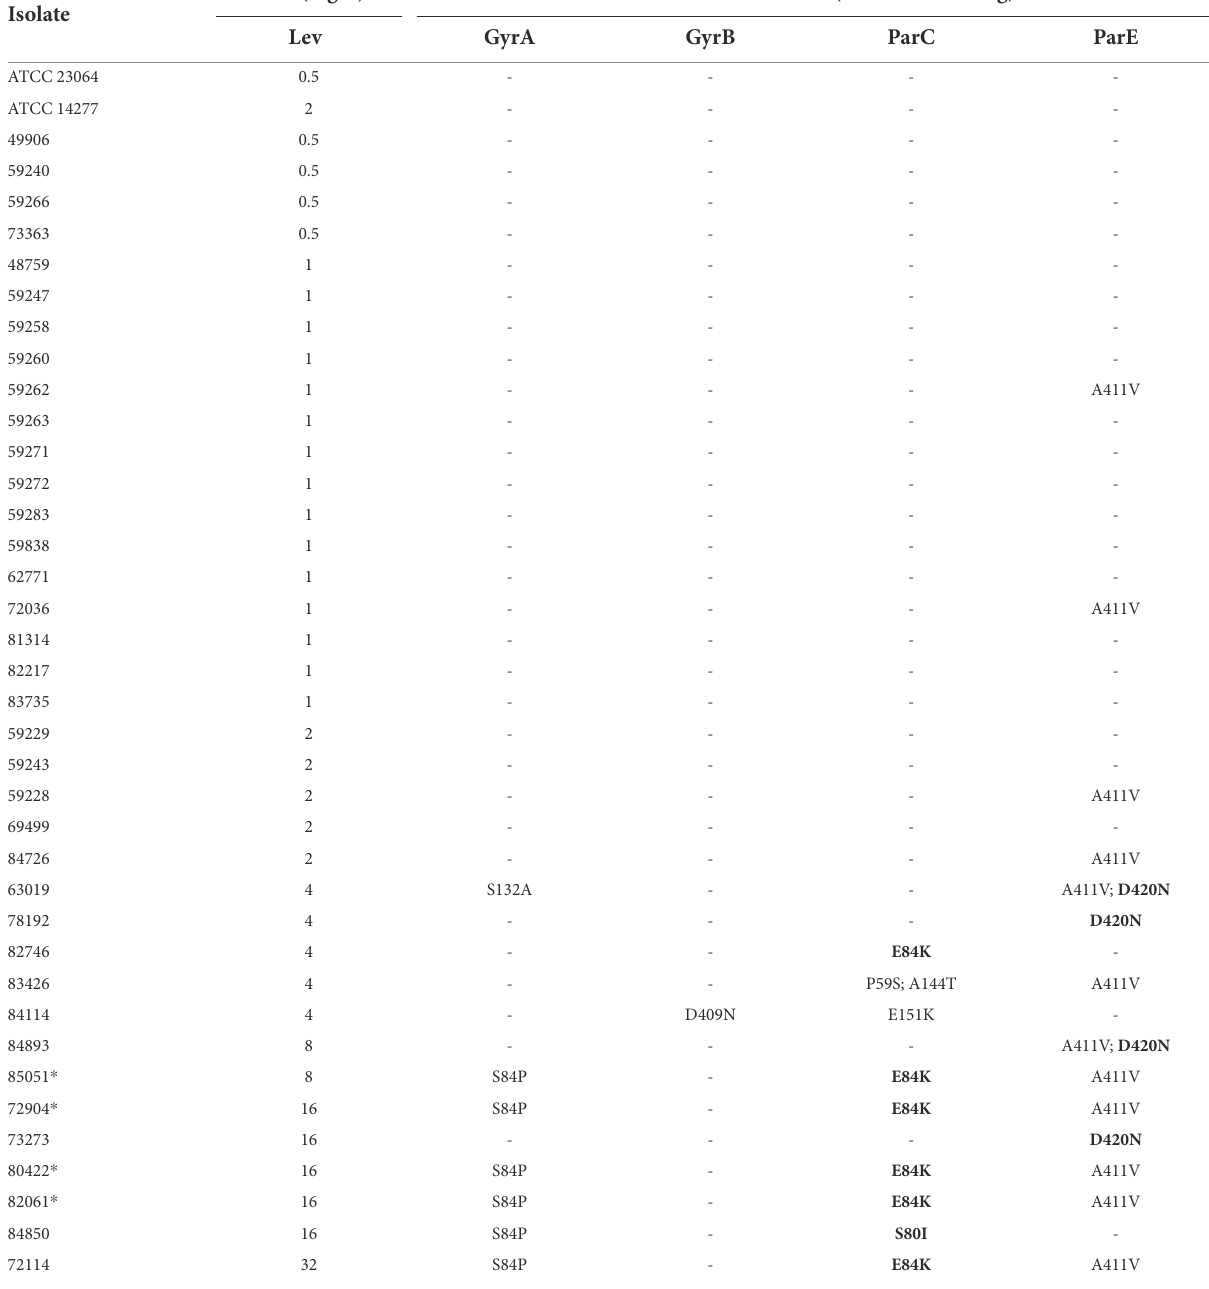
TABLE 3 Levofloxacin MIC and alterations in GyrA, GryB, ParC, and ParE proteins.